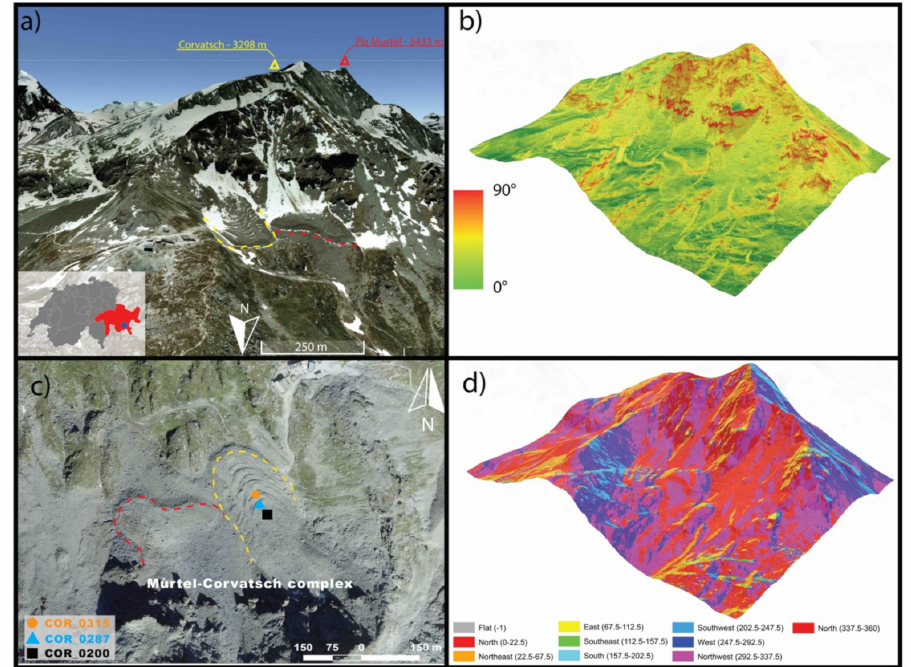
Figure 4. ( a ) Murt è l-Corvatsch rock glacier panorama; ( b ) slope chart of the area; ( c ) orthophoto of the rock glacier complex (from Google Earth, 2016) with indicated Corvatsch rock glacier (yellow dashed line) and M ù rtel rock glacier (red dashed line); ( d ) aspect chart of the